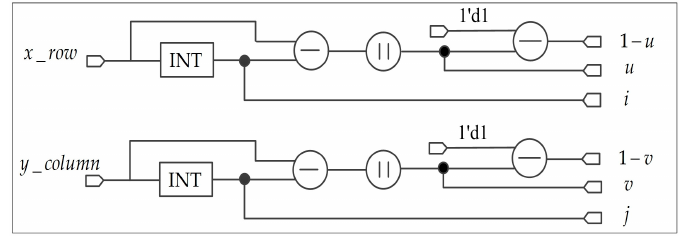
Figure 17. The parallel implementation method for i , j , u , v , 1 − u and 1 − v .